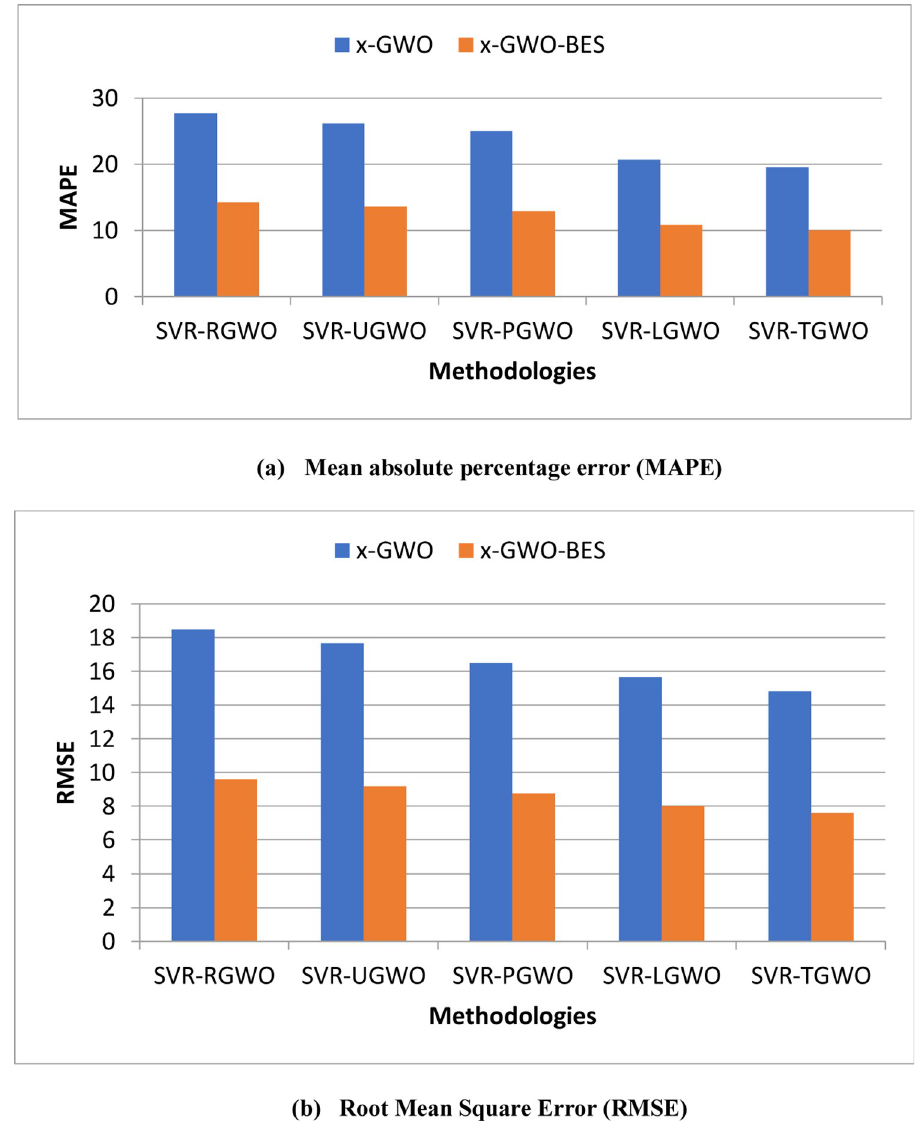
Fig 4. Analysis of hybrid GWO-BES on natural selection based GWOs (a) MAPE (b) RMSE.